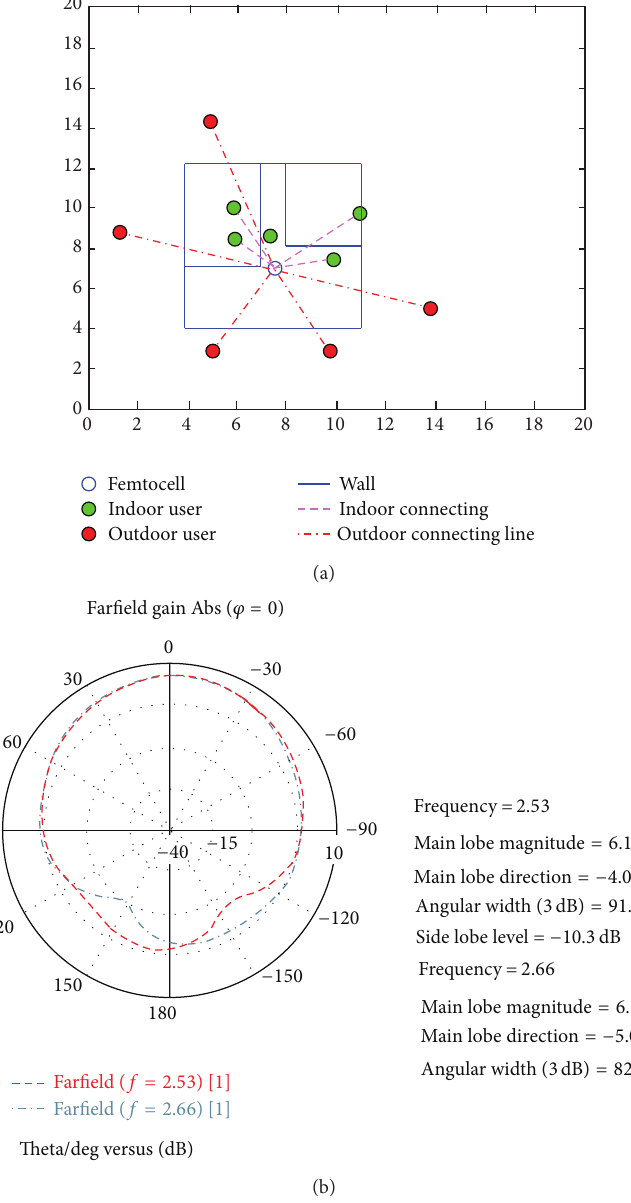
Figure 4: (a) Layout of the simulation environment. (b) Radiation pattern of the microstrip antenna at 2.53 GHz and 2.66